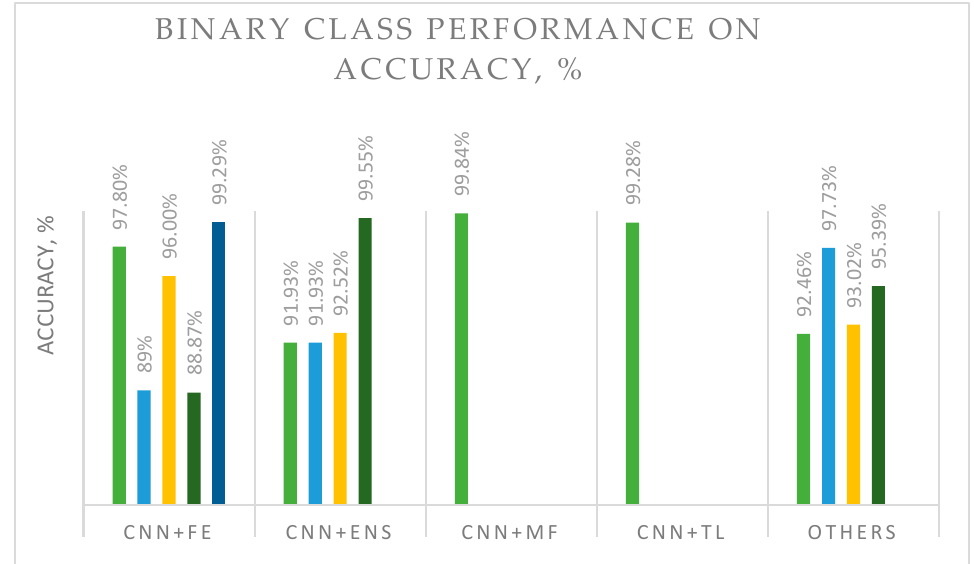
Figure 3. Binary classification accuracy of the popular and best classification approaches.